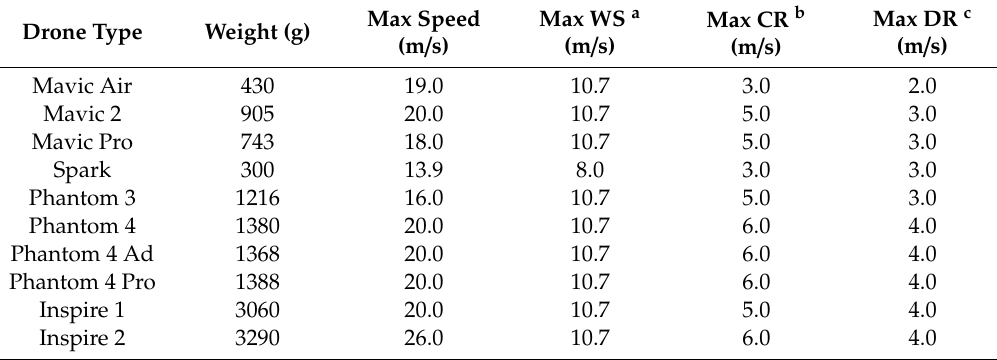
Table 1. Performance parameters of the selected